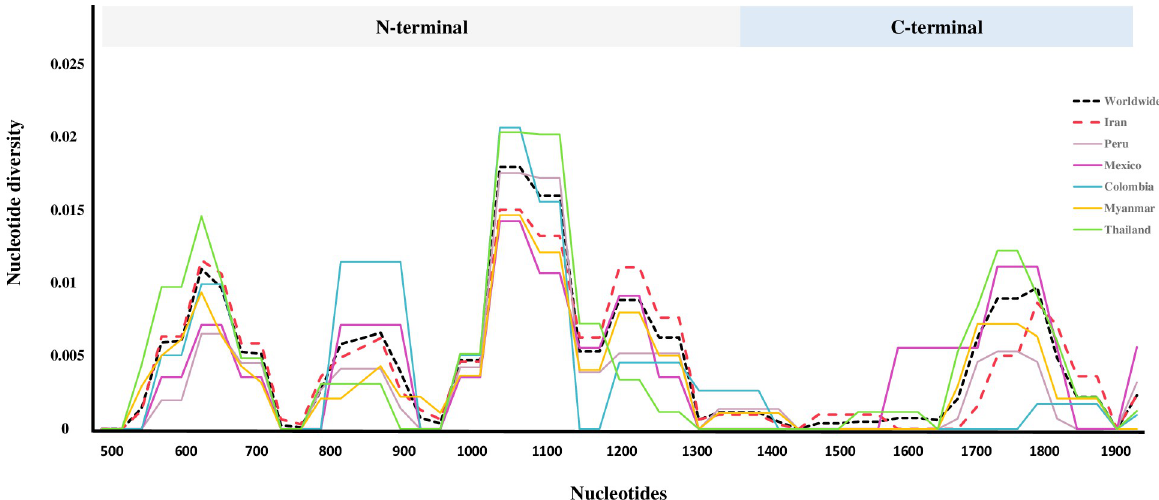
Fig 1. The plot represents the nucleotide diversity ( π ) across the global pvrbp2b DNA sequences (n = 155). The values demonstrates a window size of 100 bp with a step size of 25 bp which was calculated using DnaSP software. Nucleotides were numbered according to Sal-I reference sequence